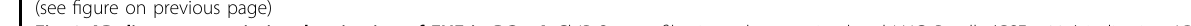
DNA sequences represented by these sites. Two putative direct AR-binding sites were selected, which are androgen- responsive element 1 (ARE1) and ARE2 (Fig. 3B).